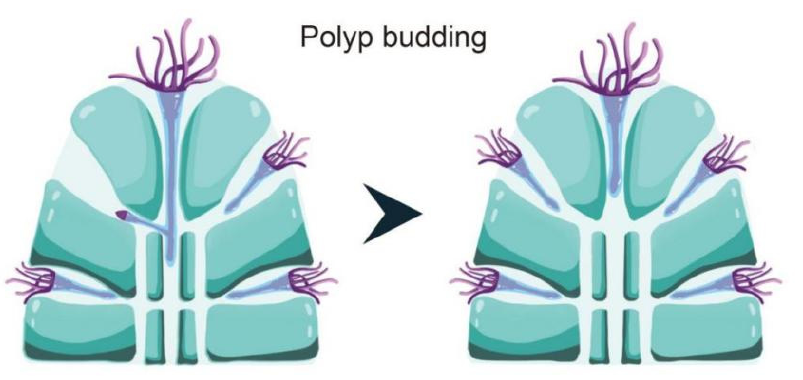
Figure 6. Polyp budding schematic according to the canal network reconstructions. The polyp buds after the mineralization of new skeletons, and the newly budded polyp migrates to its new calice through the canals.